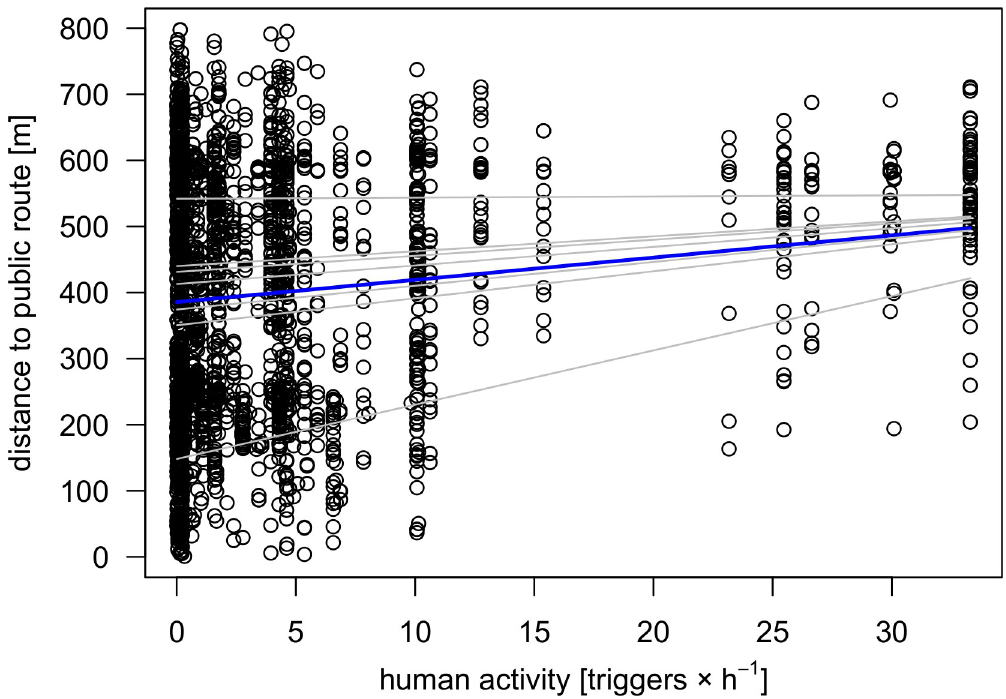
Fig 6. Human activity in the course of the day affects distribution of black grouse locations. The GPS locations (points) show the relationship between human activity and distribution of distances towards public routes. The linear mixed-effects model is plotted as a blue line; grey lines show the model’s coefficients of each individual (random factor). Human activity on routes is calculated as average number of trigger events per hour. Telemetry and human activity data were collected in different monitoring periods. The comparison of both data sets is based on the assumption of constant visitor